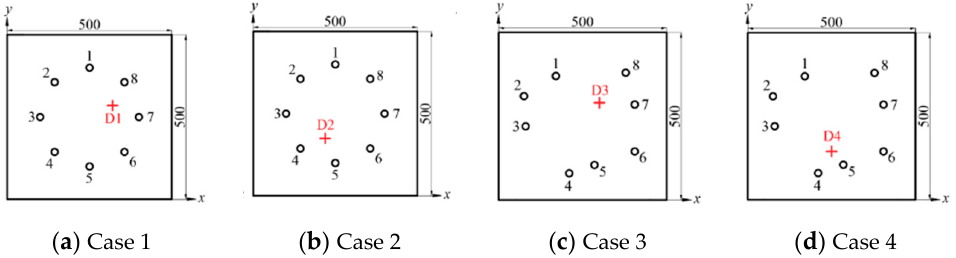
Figure 8. Position of sensors and defects. (“O” represents the positions of the sensors and “+” represents the actual positions of the defects.) Table 2. Coordinates of sensors and defects.